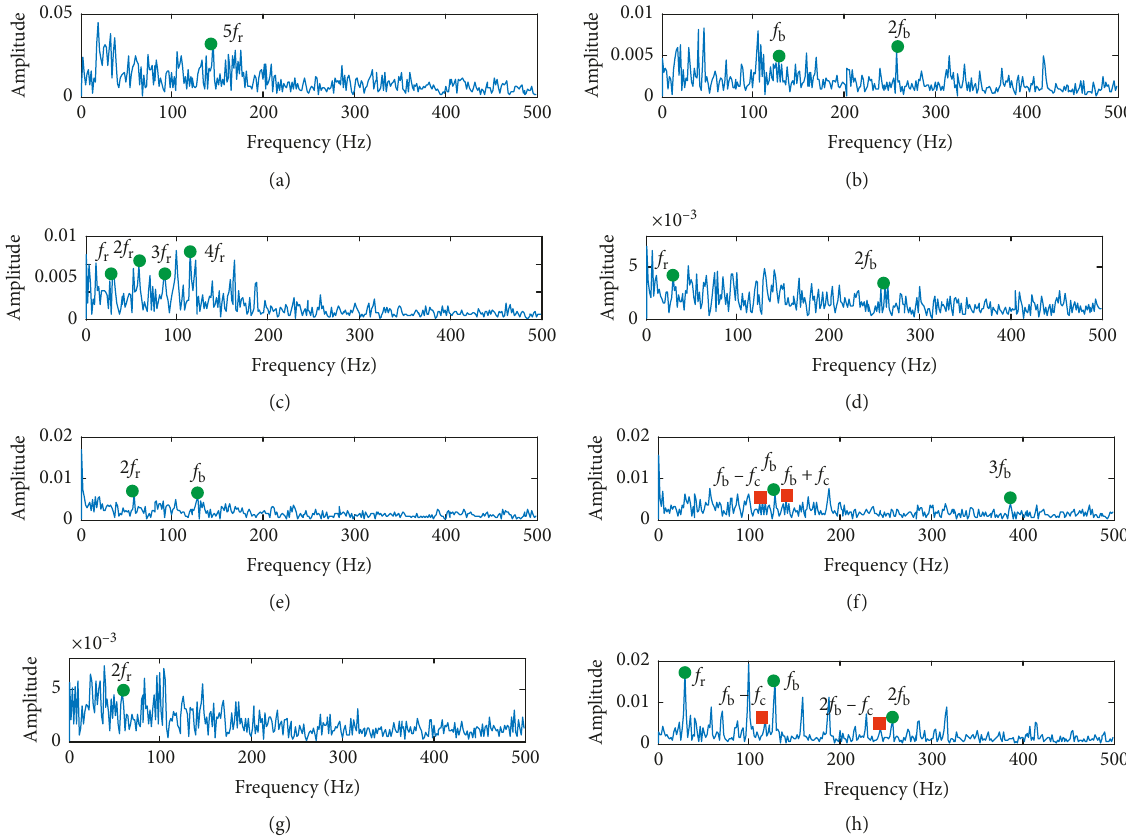
Figure 12: The frequency domain diagram of multiresolution DMD modes of the roller fault signal, where (a)–(h) are corresponding to signals in Figure 8,